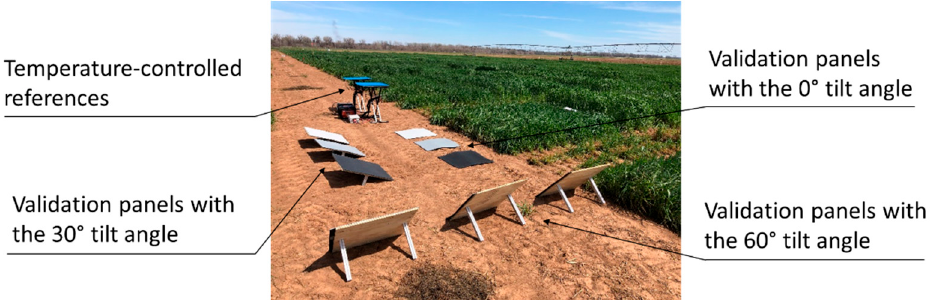
Figure 6. Temperature-controlled references, three sets of three-colored square validation panels placed on the ground at different tilt angles, and ground-truth temperature measurements.